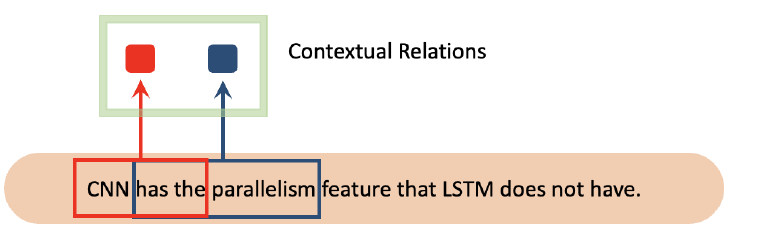
Figure 10. The convolutional processing of CNN. The red color and blue color represent two different contextual relations of corresponding words.